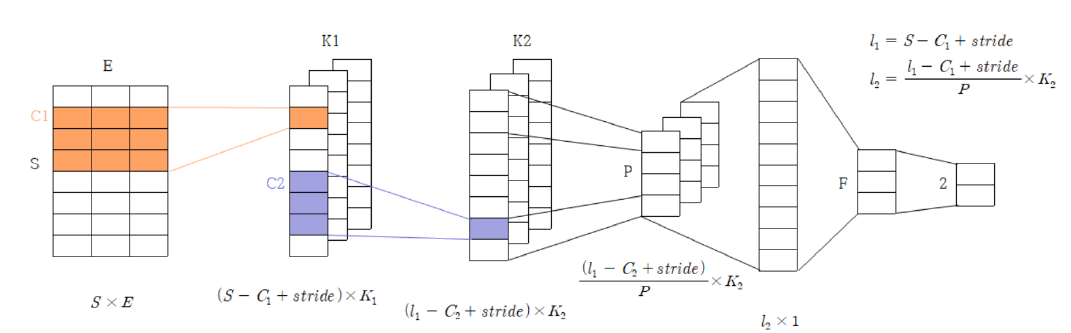
Figure 1. The graphical representation of the network, where the output dimensions of each layer are represented at the bottom of the corresponding